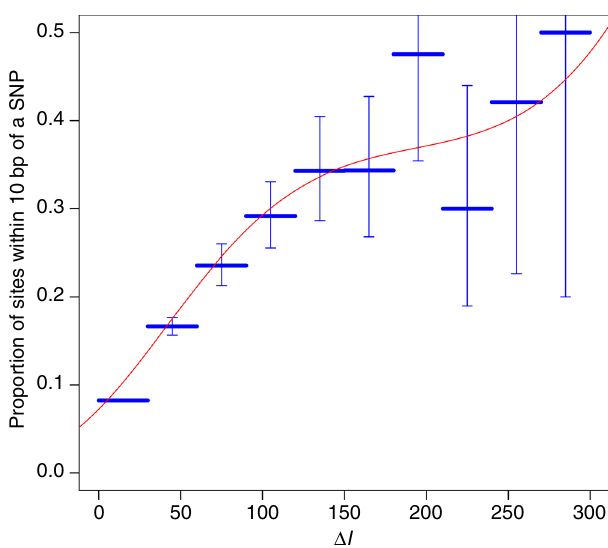
Fig. 1 Predicting genetic variation with Δ l . The proportion of methylation sites with nearby SNPs as a function of Δ l , both by categories of Δ l (horizontal lines with error bars representing 95% con fi dence intervals) and as a polynomial function fi tted by logistic regression (curvilinear